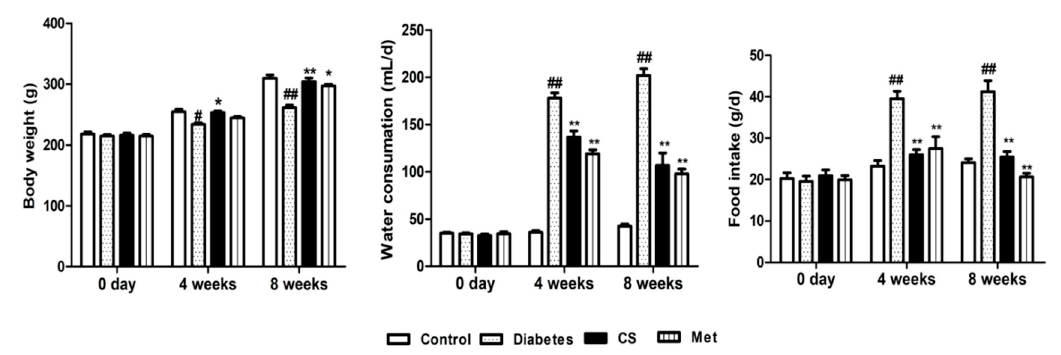
Figure 1. Body weight, water and food intake of rats in each group. ## p < 0.01 compared with the control group, # p < 0.05 compared with the control group; ** p < 0.01 compared with the diabetic group, * p < 0.05 compared with the diabetic group.